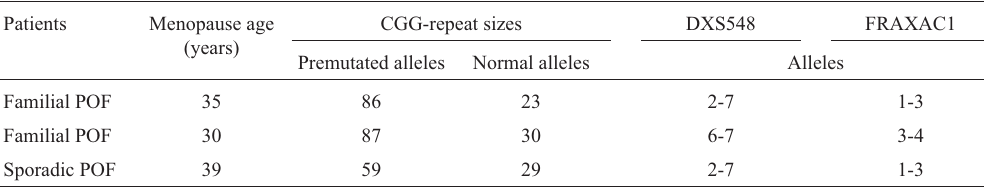
Table 1 - Premutation carriers ascertained by